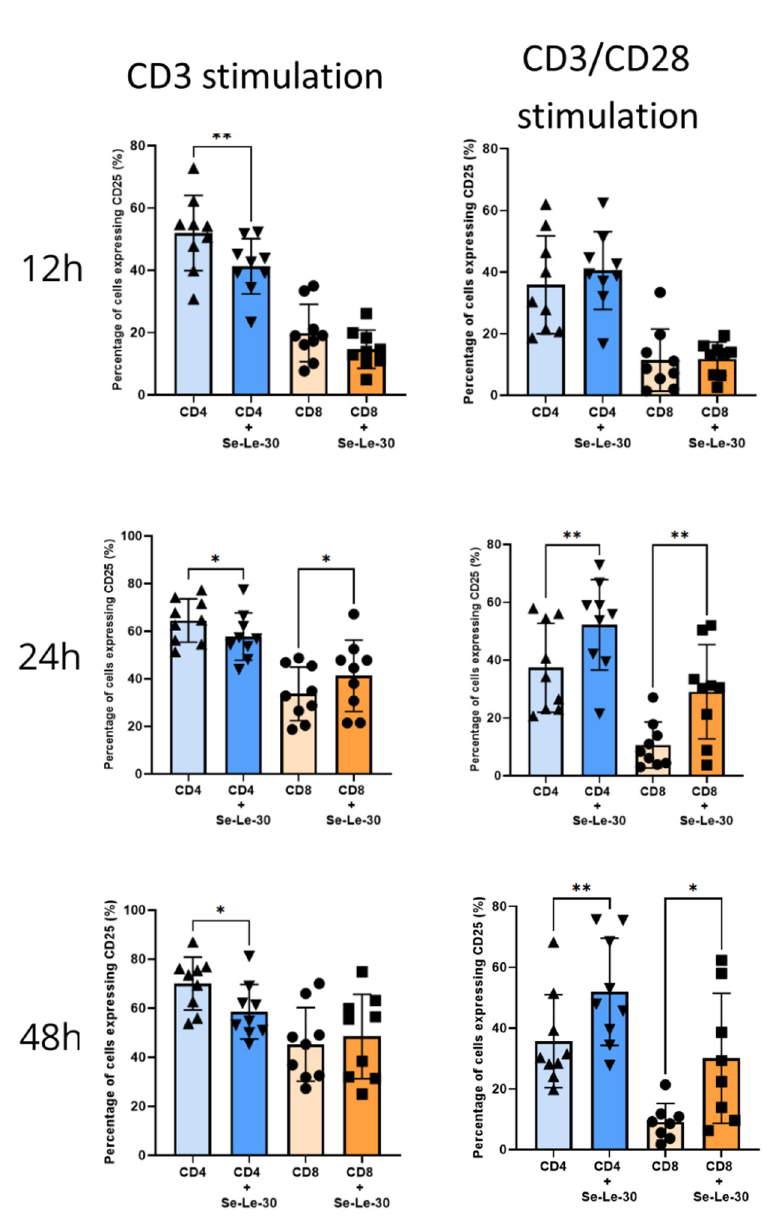
Figure 3. Effects of Se ‐ Le ‐ 30 on human CD4 + and CD8 + T cells activation. PBMCs from nine healthy donors were stimulated with anti ‐ CD3 Ab or anti ‐ CD3/CD28 Abs and treated with Se ‐ Le ‐ 30 (100 μ g/mL) for 12, 24, or 48 h. The expression of the CD25 marker on the surface of CD4 + and CD8 + T cells was detected by flow cytometry. * p < 0.05; ** p < 0.01. Points on bar charts represent experiments conducted with individual